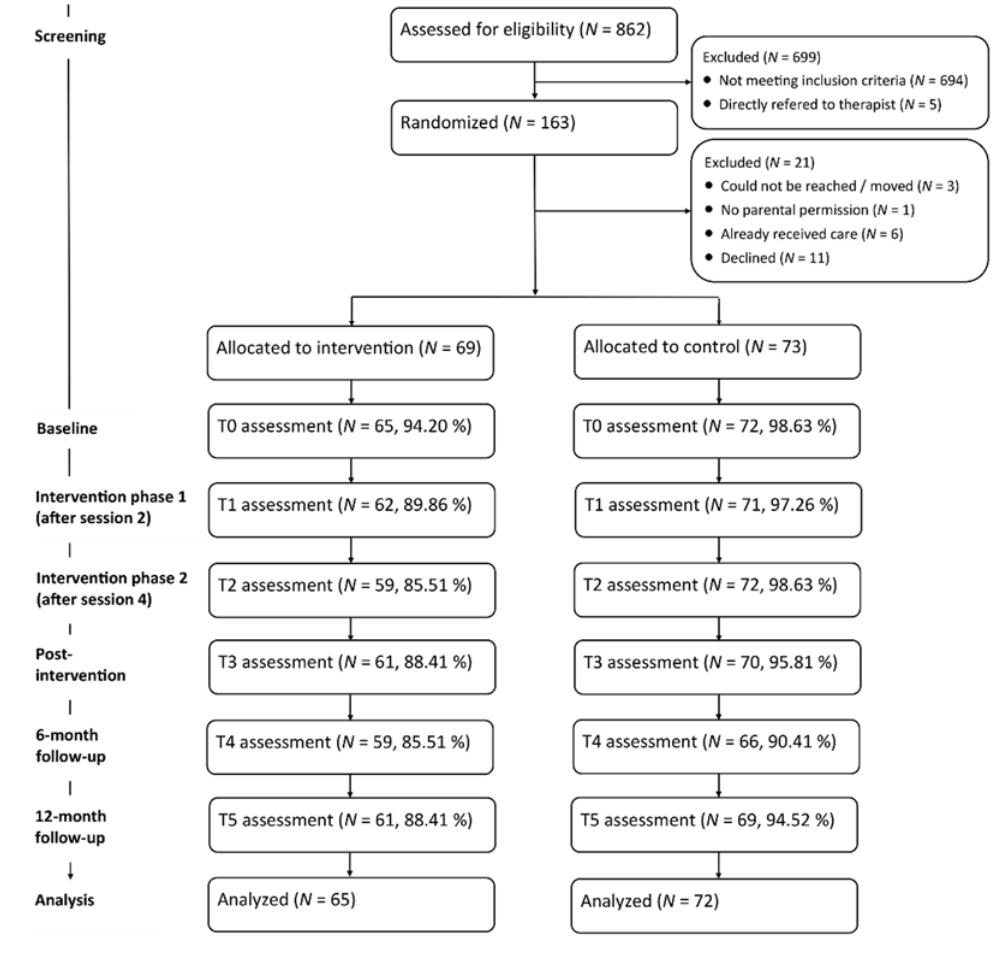
Figure 1. Flow diagram of participants.